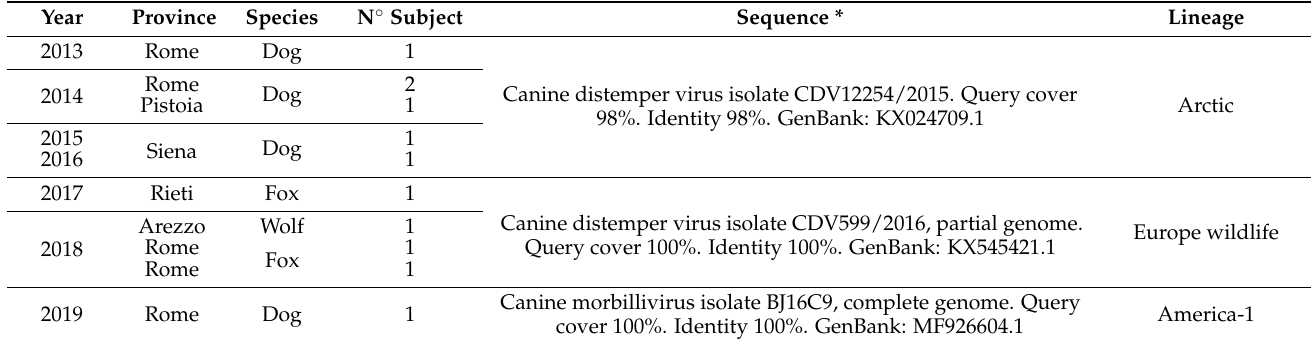
Table 5. Strains identified for the positive subjects collected between 2011 and 2019.